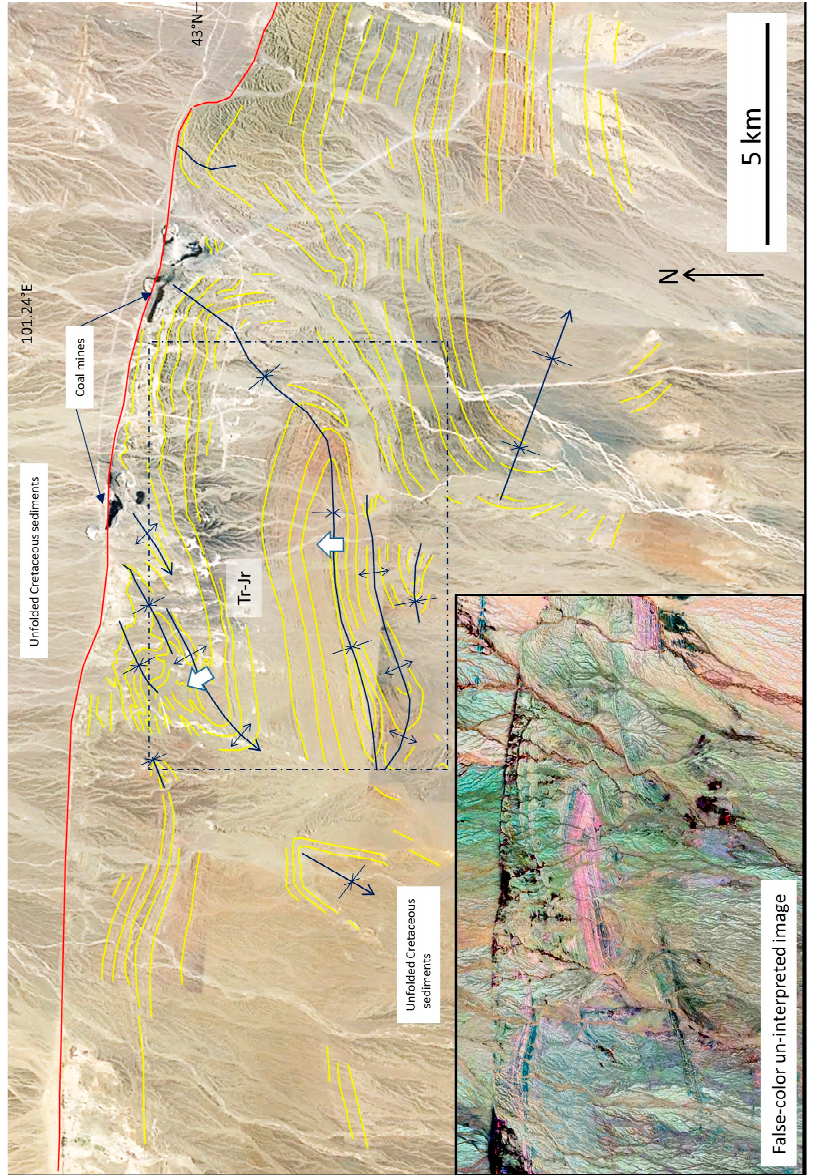
Figure 3. Google Earth (© 2016 DigitalGlobe) image interpretation showing bedding traces (yellow lines) and major fold hinges in mid-upper Triassic-Jurassic (Tr-Jr) succession in southern Noyon Uul region, southern Mongolia. Red line is major fault. Inset shows Landsat TM MrSID (N-47-40_2000) un-interpreted scene that was linearly contrast stretched, filtered (3 × 3 median), and color enhanced using the Global Mapper Difference tool. See Figure 1 for